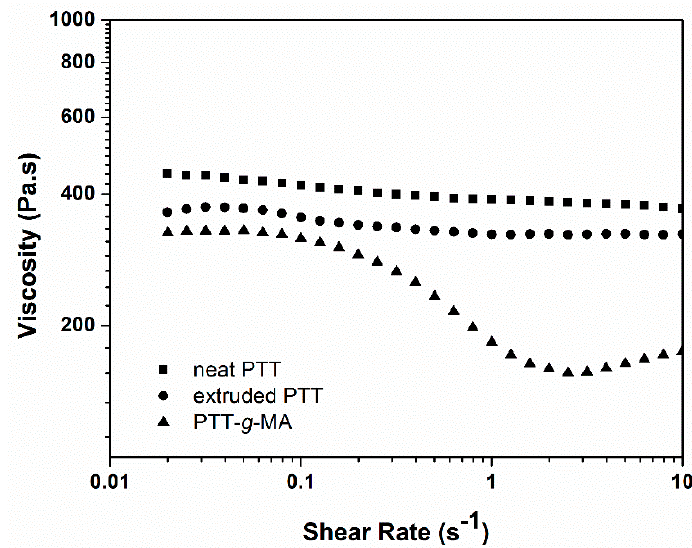
Figure 3. Viscosity curve as a function of the shear rate obtained by deformational rheometry of PTT, extruded PTT and PTT-g-MA.